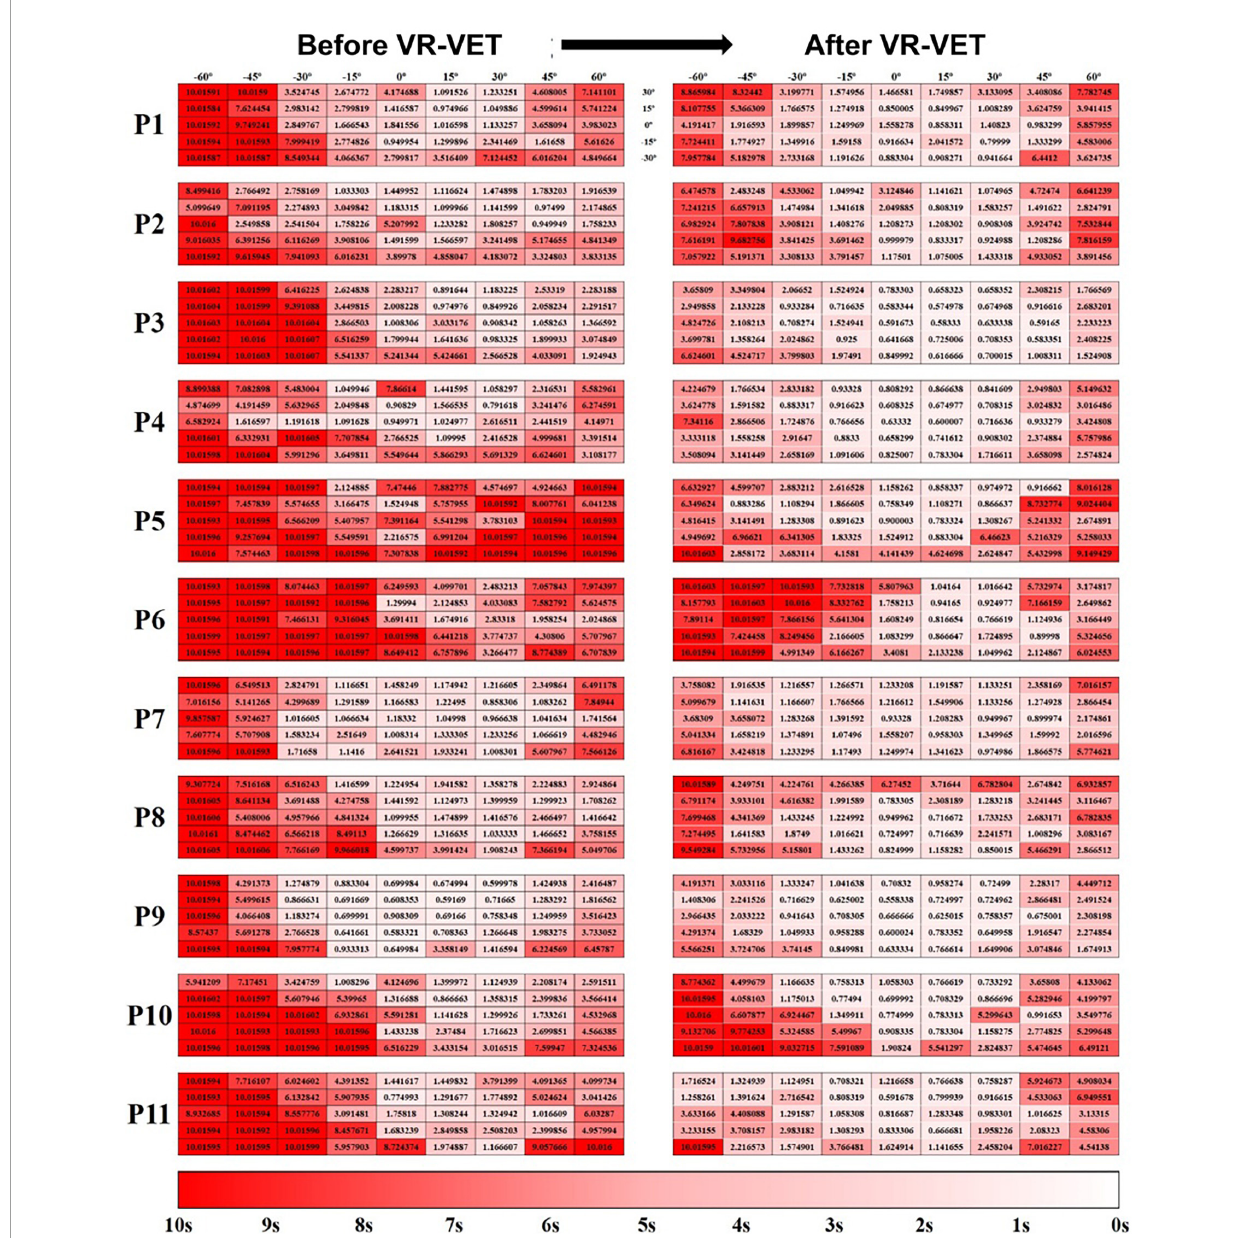
FIGURE6 Hit-map of the field of regard (FOR) response times. (Left panel) Before VR-VET training and (right panel) after 20 sessions of VR-VET. Response times close to 0 s are shown in white, and those close to 10 s are shown in red. P, participant; VR-VET, virtual reality-based visual exploration therapy.